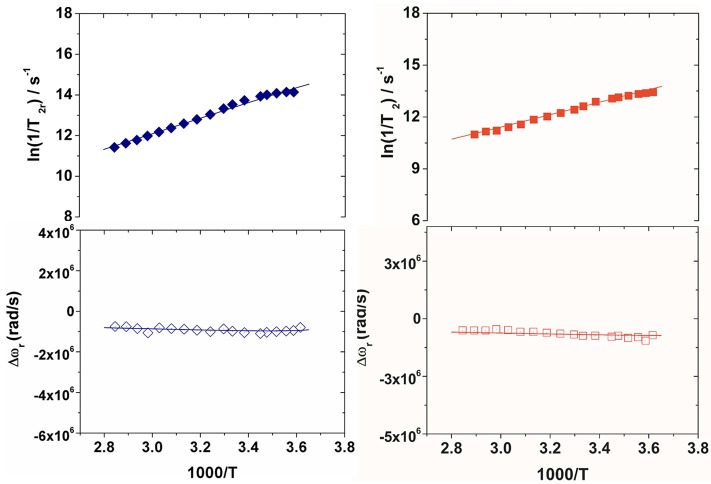
Reduced transverse 17O relaxation rates (top) and chemical shifts (bottom) measured at 11.74 T (pH 7) for Gd2L1 (left) and Gd2L2 (right). The solid lines correspond to the fits of the data as described in the text.